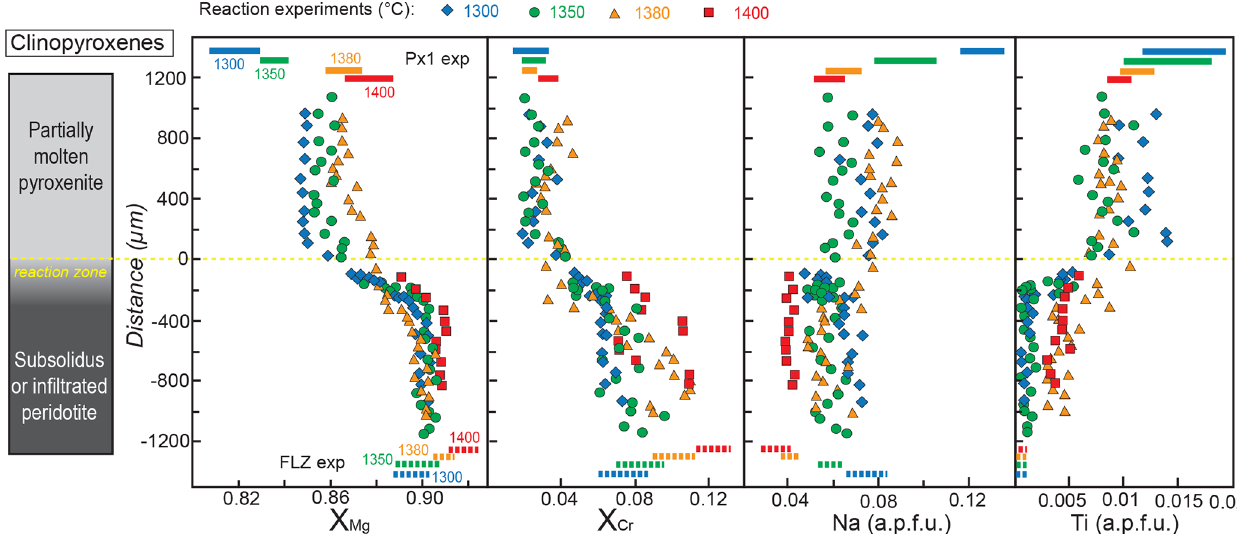
Figure 7. Profiles of X Mg [ X Mg = Mg /( Mg + Fe tot ) ] , X Cr [ X Cr = Cr /( Cr + Al ) ] , Na and Ti contents (a.p.f.u.) in clinopyroxene along the charges after reaction experiments at 2GPa. Analyses were performed on the cores of grains with variable size ( > 5µm). Distance = 0µm marks the interface between the partially molten pyroxenite and the orthopyroxene-rich reaction layer. Dashed lines at the bottom represent the compositional range measured in clinopyroxene from FLZ experiments at 2GPa and 1300–1400 ◦ C. Coloured bars at the top of the diagrams indicate the compositional variability observed in melting experiments on Px1 at 2GPa and 1300–1400 ◦ C (data from Borghini and Fumagalli, 2020). The inset on the left schematically illustrates the run products with partially molten pyroxenite, reaction zone and peridotite layer from top to bottom of the charges, respectively. Pyroxenite does not contain clinopyroxene as a stable phase in reaction experiments at 1400 ◦